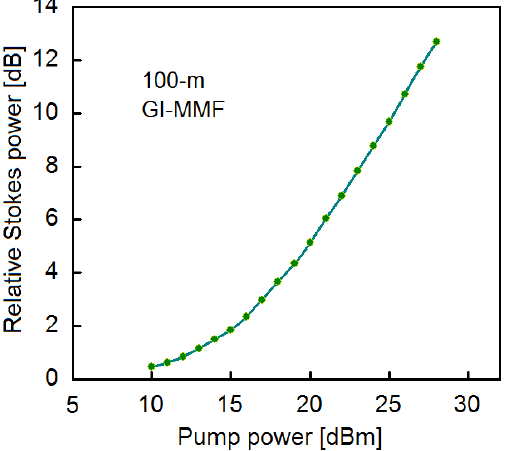
Figure 5. Relative Stokes power as a function of pump power in the 100 m GI-MMF.